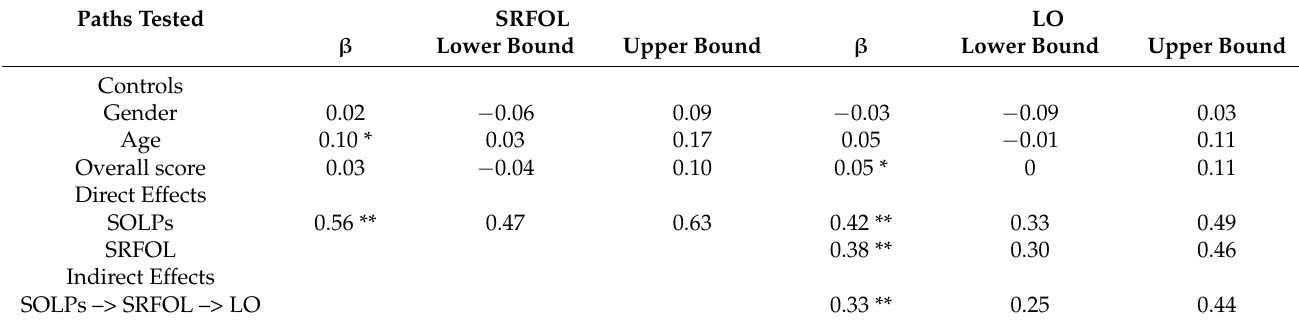
Table 5. Structural model results for direct and indirect effects.